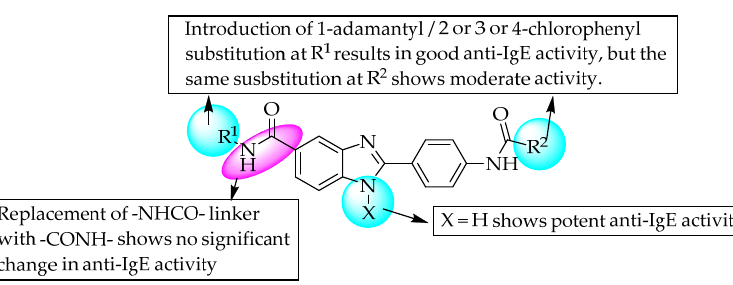
Figure 35. SARs of adamantane-substituted benzimidazoles.